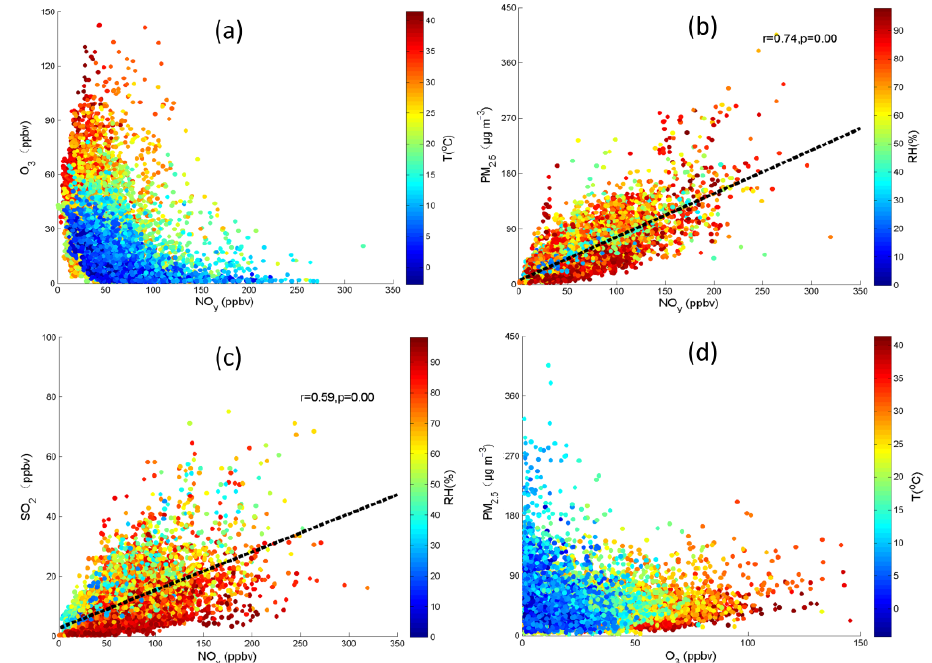
Figure 3. Scatter plots of NO y with O 3 (NO y –O 3 ) color-coded with air temperature (a) , NO y –PM 2 . 5 color-coded with relative humidity (b) , NO y –SO 2 color-coded with relative humidity (c) , and O 3 –PM 2 . 5 color-coded with air temperature (d)